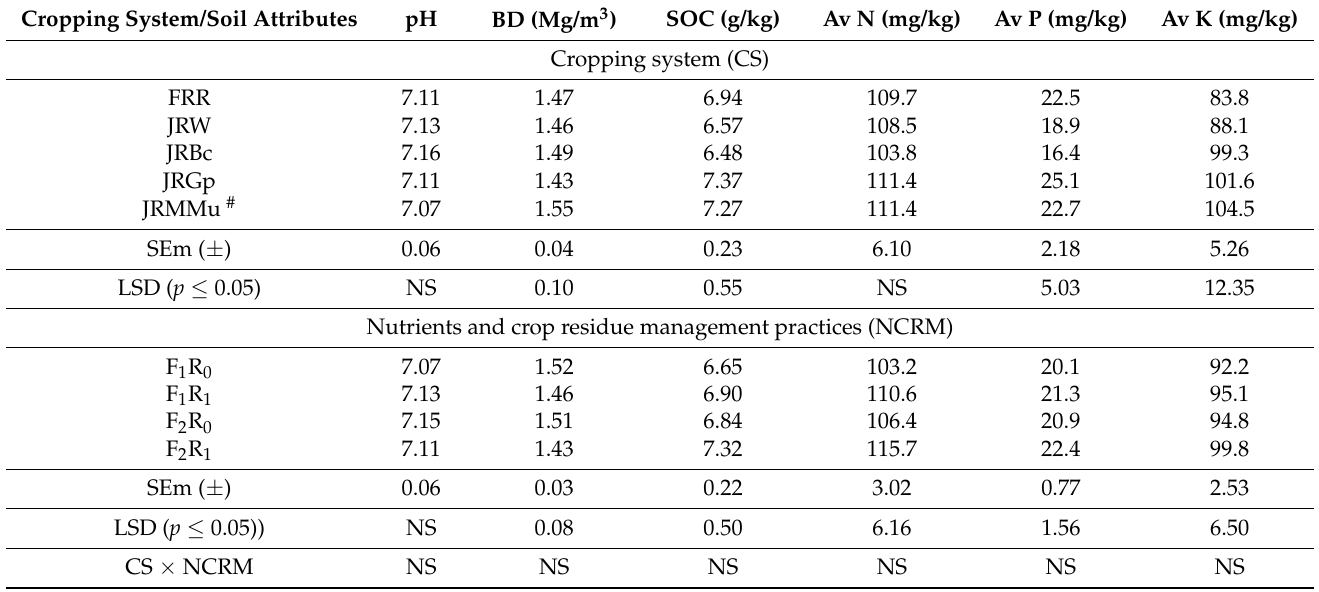
Table 2. Soil physio-chemical properties influenced by different cropping systems and nutrient and crop residue manage- ment practices. Cropping System/Soil